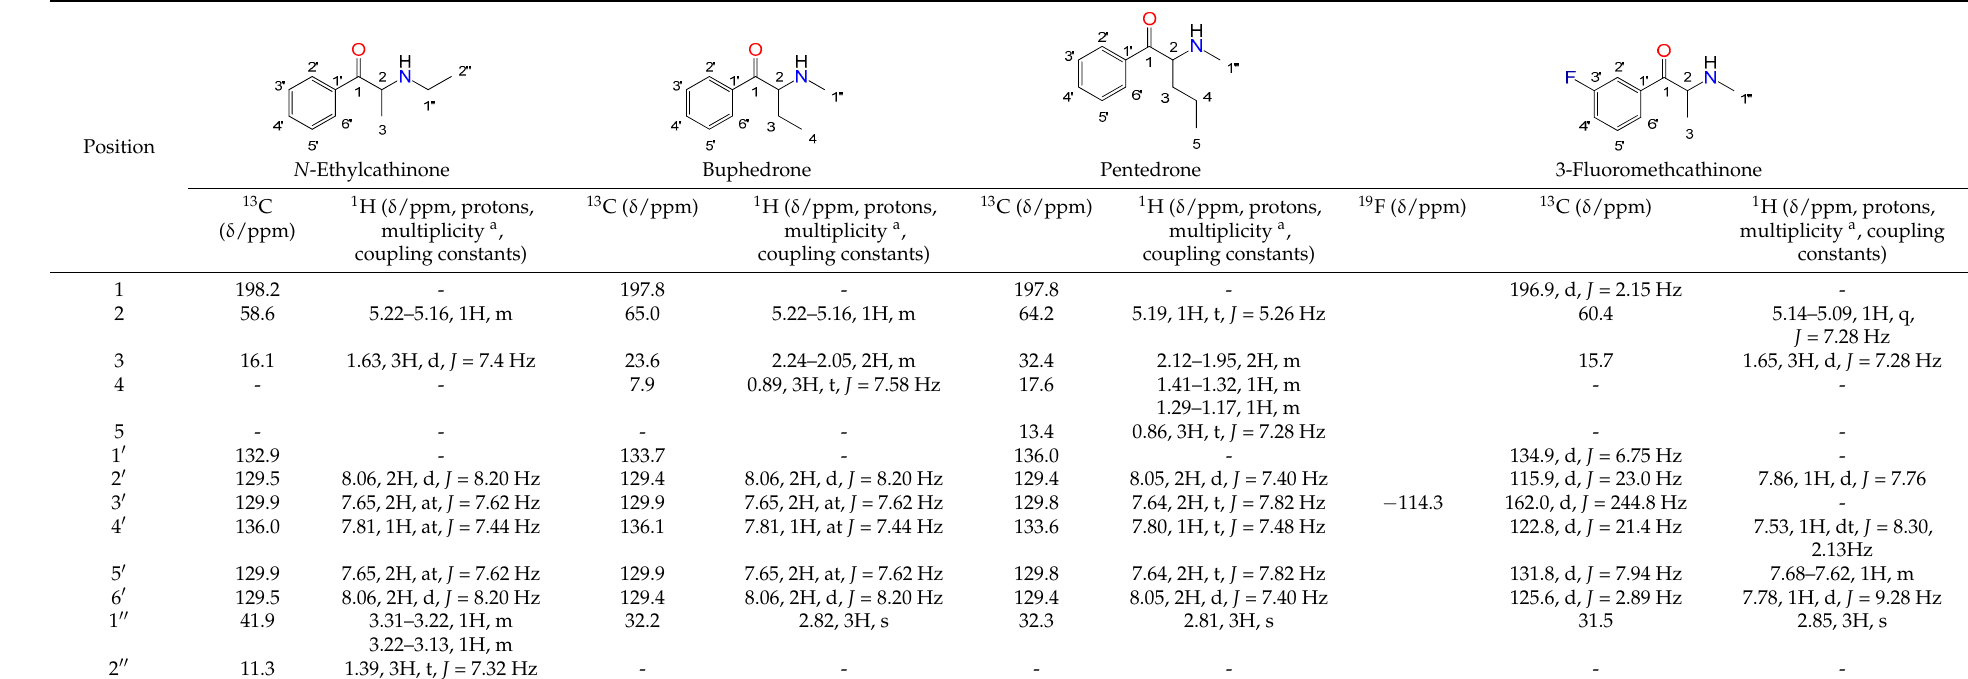
Table 4. NMR assignments of N -ethylcathinone, buphedrone, pentedrone and 3-FMC found in seized materials.